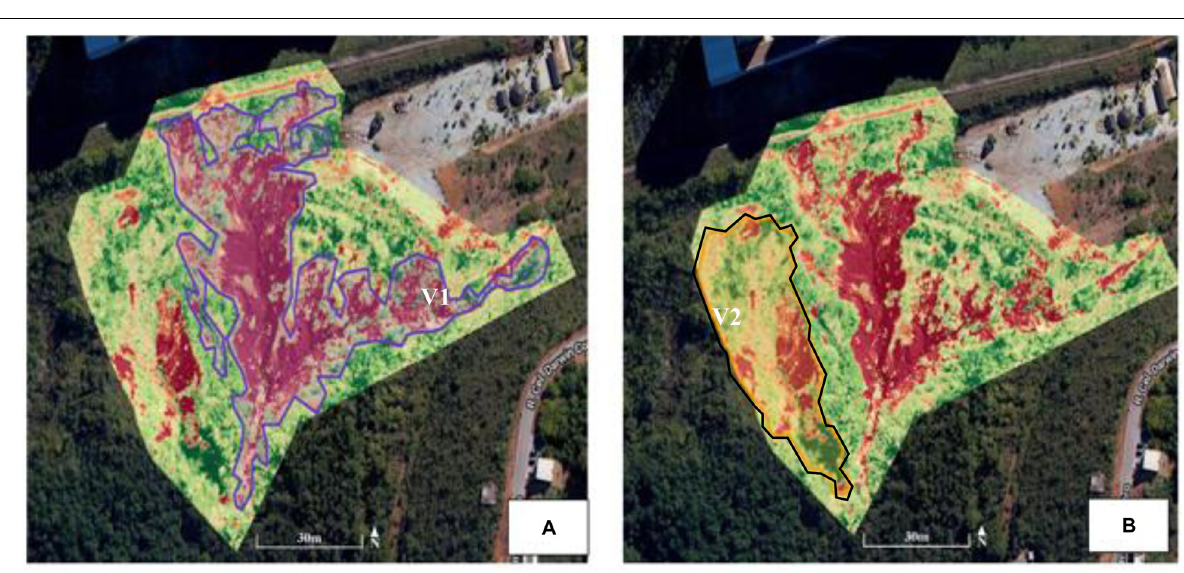
FIGURE 13 | Vegetation and bare soil in gullies V1 and V2. Red tones = bared soil; green tones = vegetation. (A) The lines delimit the gully V1; (B) the lines delimit the gully